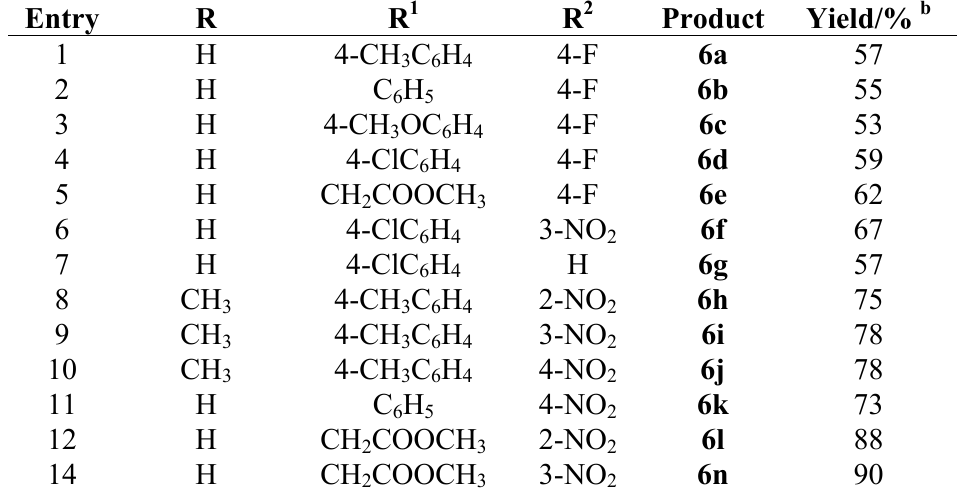
Table 1. The results of the preparation of 1,3-benzoxazines 6 a